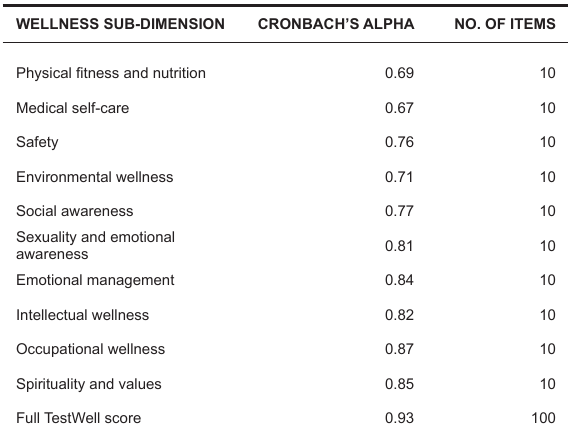
TABLE 1 Cronbach’s alpha for the wellness sub-dimensions